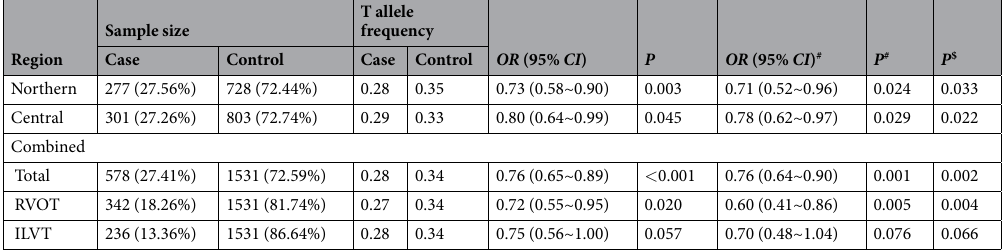
Table 2. Allelic association of rs12143842 with IVT in the Northern and Central cohorts. # Adjusted by age, sex. $ Empirical P values were derived by performing 1,000 Monte–Carlo